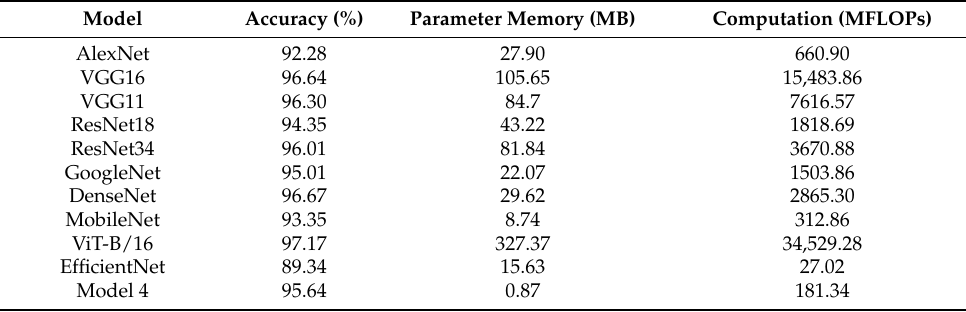
Table 4. Performance comparisons of proposed Model 4 with classical